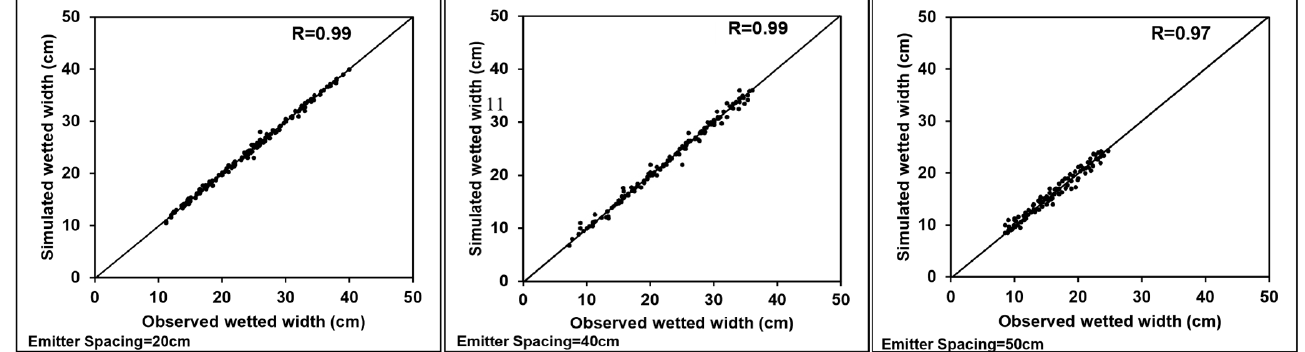
Figure 9. Simulated vs. observed wetted width at the first and last cross-sections of drip laterals with emitter spacing of 20, 40, and 50 cm.